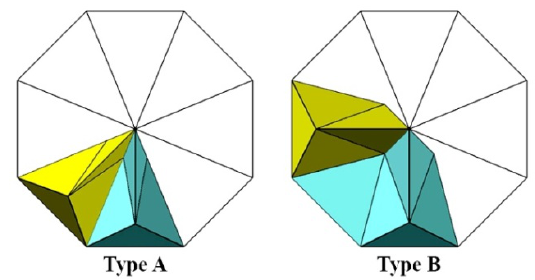
Figure 3. Methodof generating the Concave pyramids of second sort, type A and type B